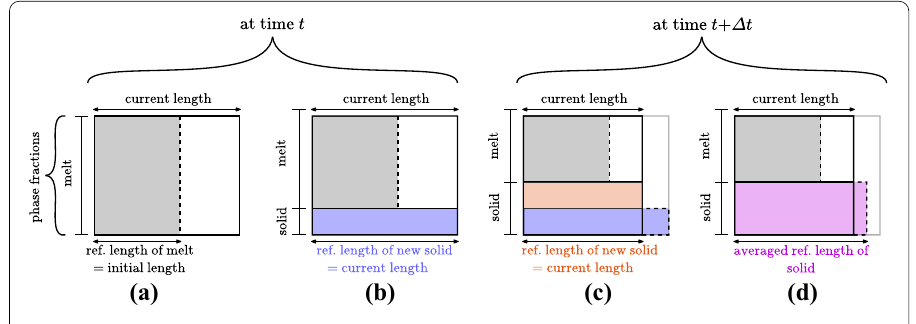
Fig. 1 Effect of the reference strain contribution during solidification in a one-dimensional setting. Different phase fractions are distinguished in vertical direction together with their respective reference length, visualized in horizontal direction. At time t , starting from a fully molten phase ( a ), a fraction of material solidifies ( b ) and due to the calculation of the reference strain effectively takes on a new reference configuration equal to the current configuration (blue). At time t + (cid:9) t , the newly solidified fraction takes on the (now changed) current configuration (red) as reference configuration ( c ), such that the effective reference strain (which in fact is calculated in the proposed model) in the (total) solid phase can be interpreted